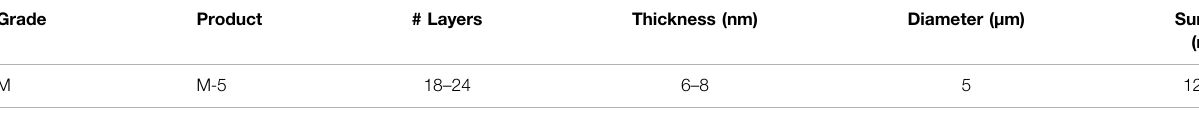
TABLE 1 | XG Sciences xGNP ® grade M GNP technical speci fi cations.